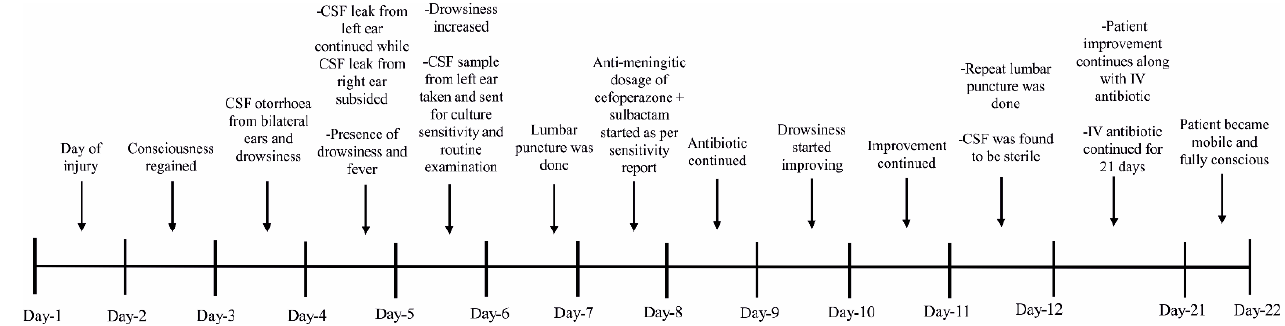
Figure 2. Timeline of disease aggravation of the affected patient and subsequent management of the disease by proper antibiotic treatment. (CSF-Cerebrospinal Fluid, IV-Intravenous). Table 1. Antibiogram profiling of Acinetobacter lwoffi showing sensitivity to various antibiotics (R— resistant; S—sensitive; IM—intermediate).